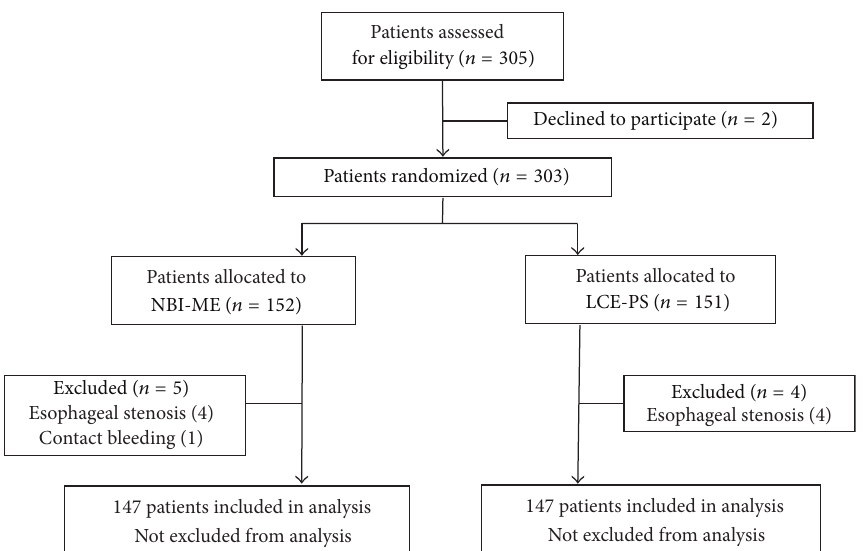
Figure 3: Overview of the study design. NBI-ME : narrow-band imaging magnifying endoscopy; LCE-PS : Lugol chromoendoscopy with pink-color sign